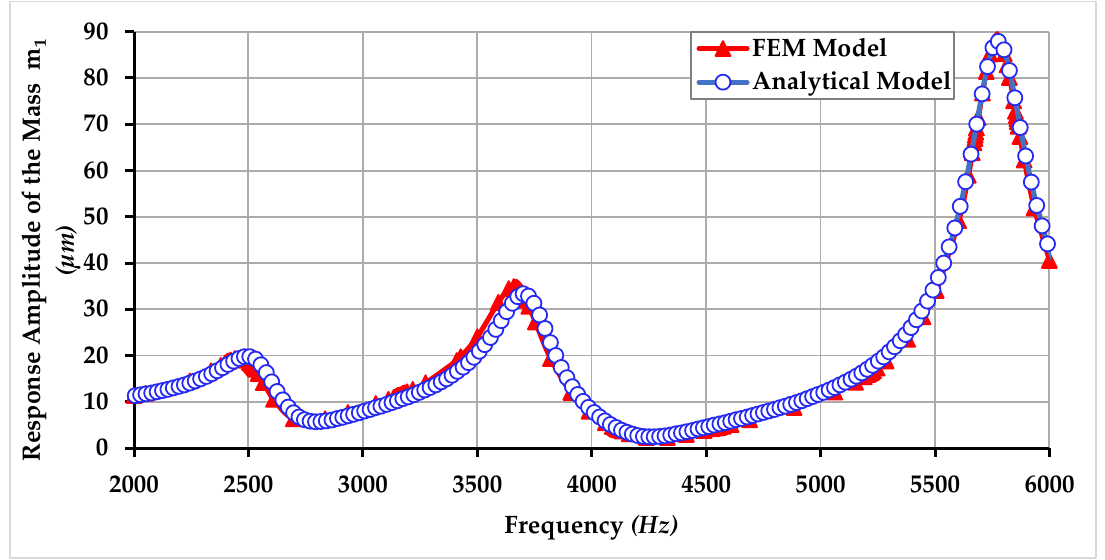
Figure 22. Comparison of response amplitude of the mass 𝑚 1 of the proposed MEMS gyroscope obtained using FEM and an analytical model. Micromachines 2018 , 9 , x